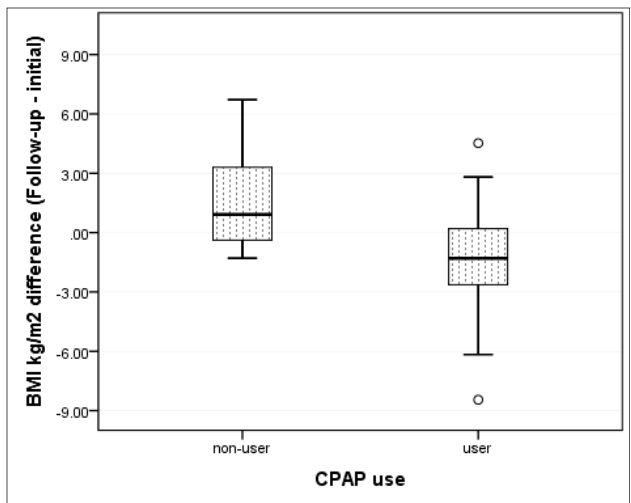
Figure 2. Change from baseline to follow-up in mean BMI according to CPAP usage status. (CPAP—continuous positive airway pressure; BMI—body-mass index; small size circles in the graph represent outliers).